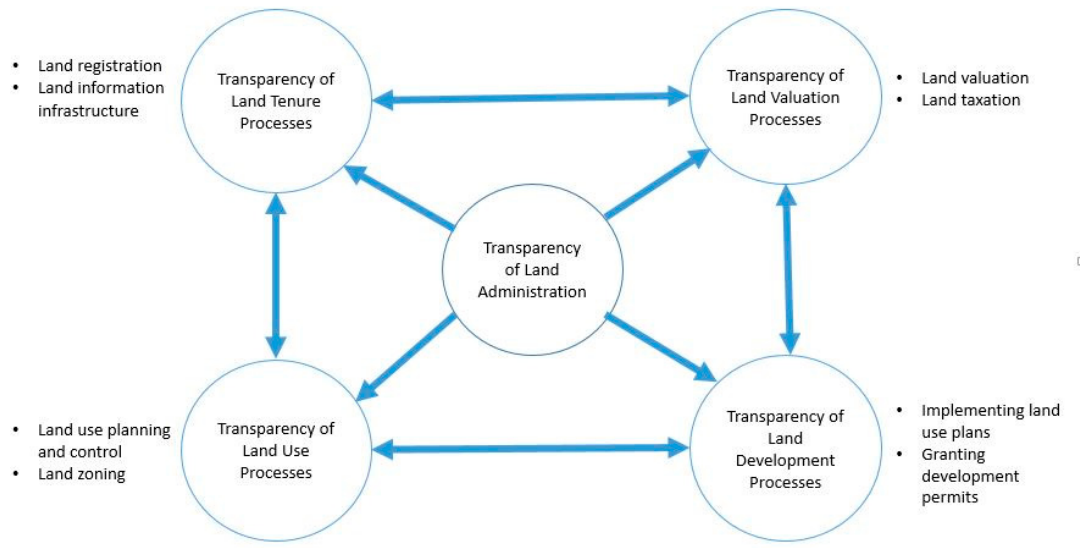
Figure 7. Transparency of the land administration framework. Source: authors’ construct based on [30,55].